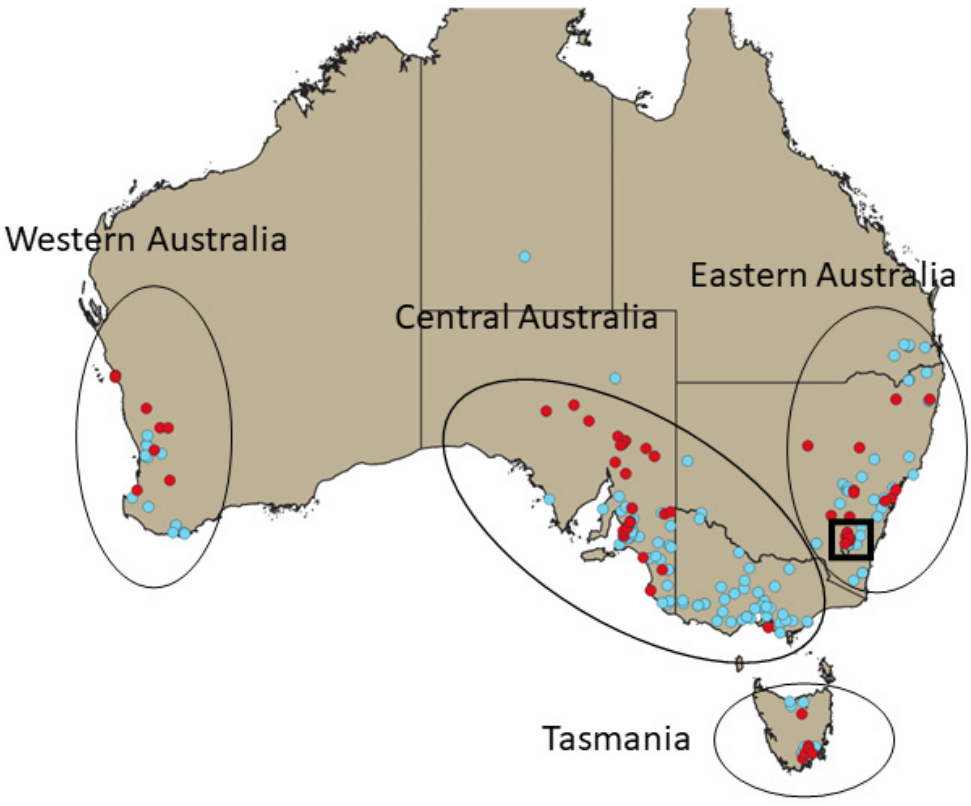
Figure 1. Map showing the sampling locations for RHDV1 (red) and RHDV2 (cyan) sequences and the four regions these were classified into. Thick square indicates samples collected in proximity to the Australian Capital Territory (ACT).